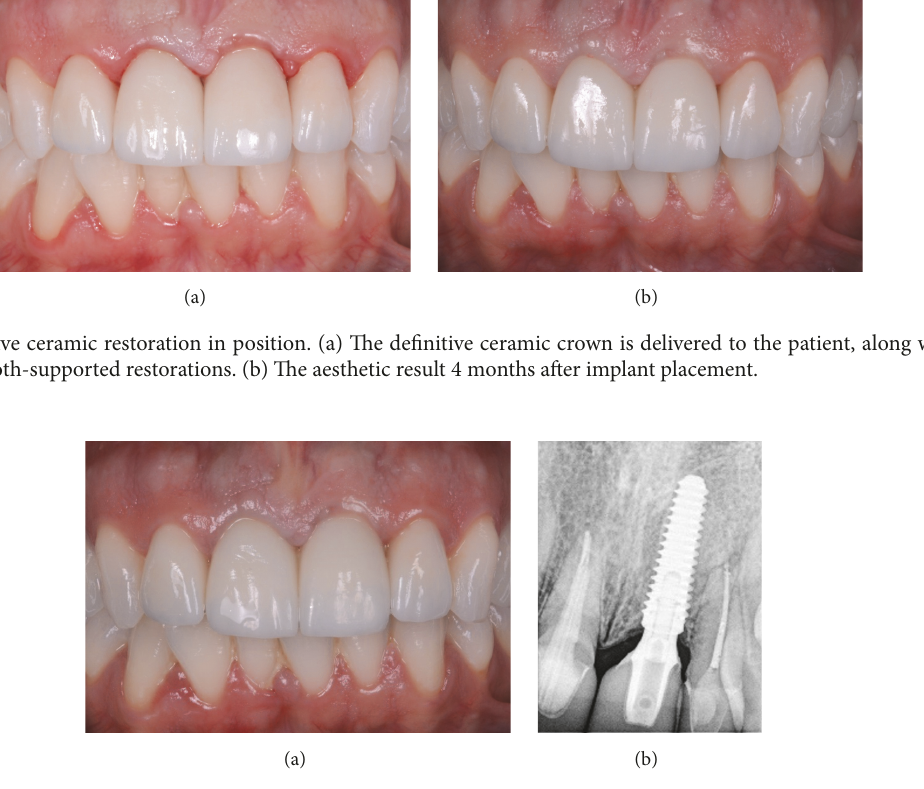
Figure 8: The definitive ceramic crown 1 year after the delivery. (a) An aesthetically pleasing result has been maintained clinically, and the patient is fully satisfied; (b) the radiographic control confirms the stability of the hard tissues around the